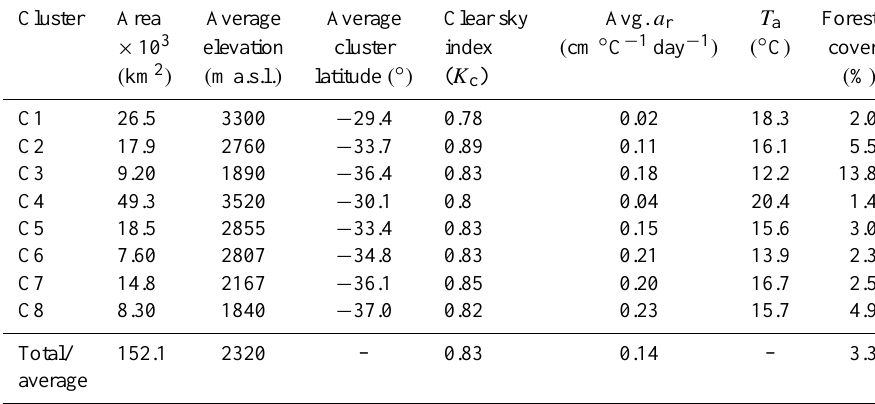
Table 1. Study area subdivision, relevant characteristics and model parameters.